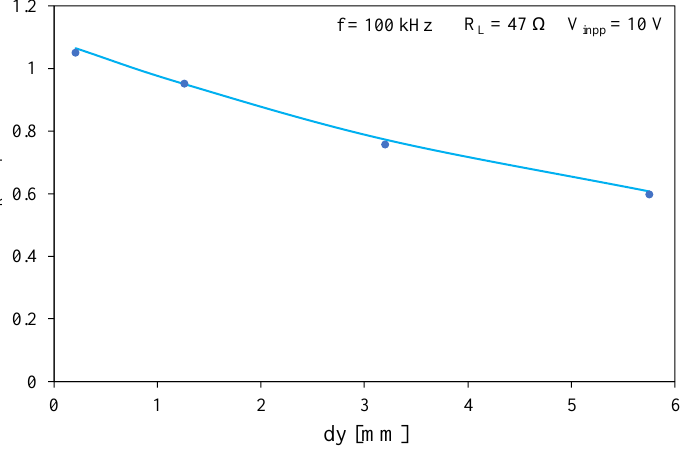
Figure 13. Dependence of the transformer voltage ratio on the distance between transformer coils.